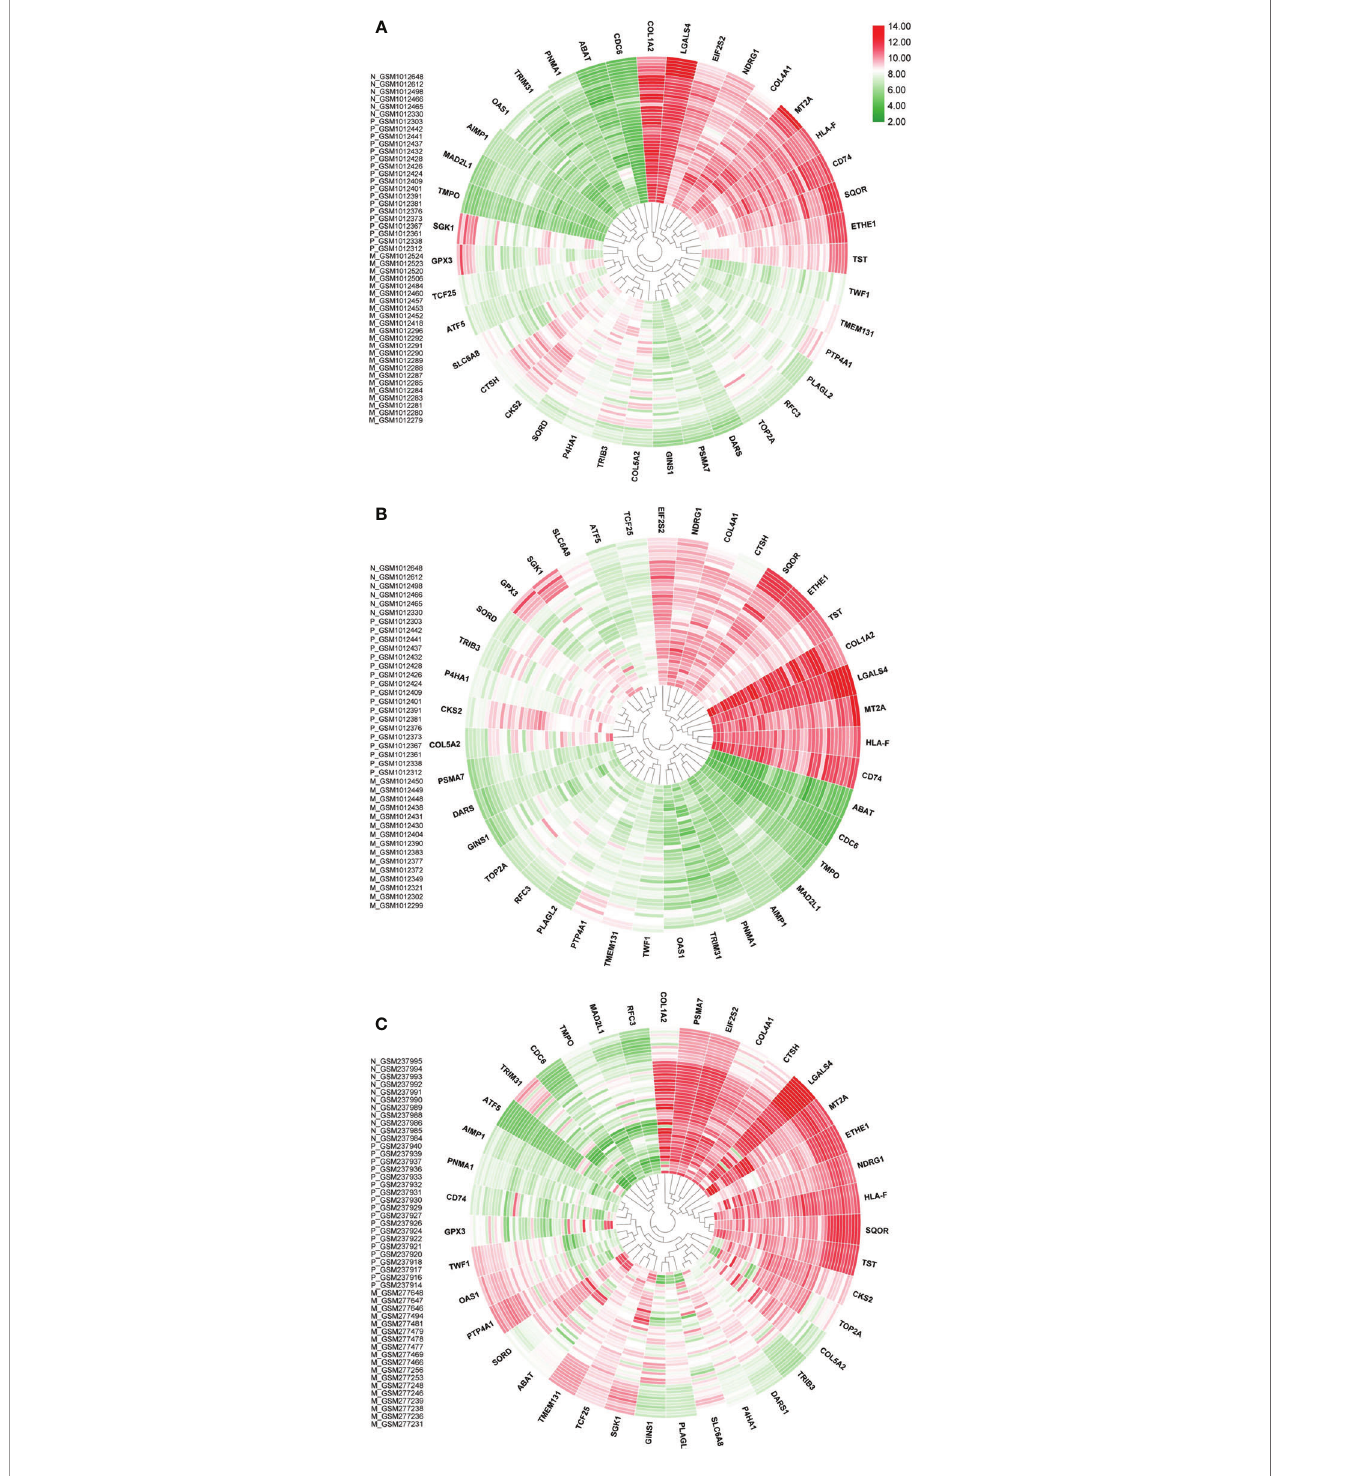
FIGURE 5 | Core network genes heatmaps. (A) is dataset1, (B) in dataset2 and (C) is dataset3. Values were obtained from expression matrices, Log2 transformed and normalized by quantile method. Sample IDs are placed in the left-hand side of each plot. Normal samples start with N, Primary samples start with P and liver and lung metastatic samples start with M. Outer samples are normal, middle samples are primary and inner samples are metastatic. Genes were clustered together based on hierarchical